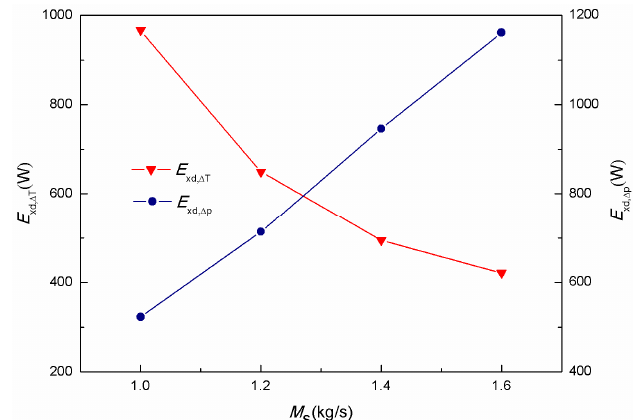
Figure 13. The distributions of the local heat transfer exergy destruction rate for different sinter mass flow rates.